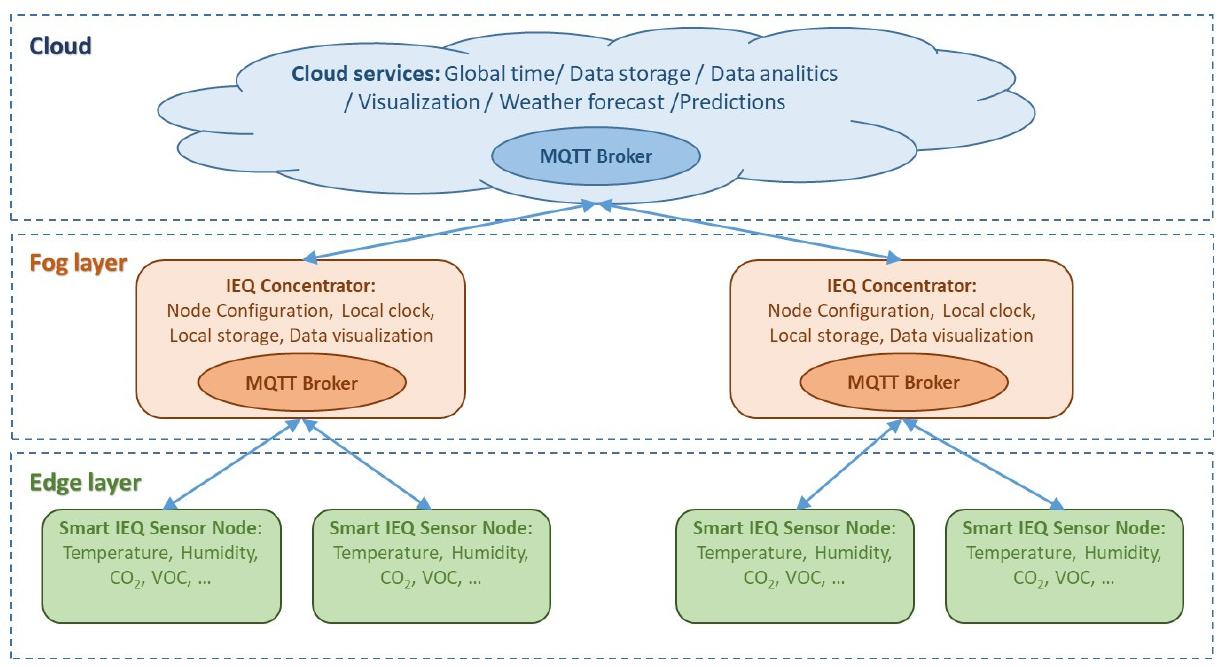
Figure 1. Overall architecture of the wireless acquisition system.